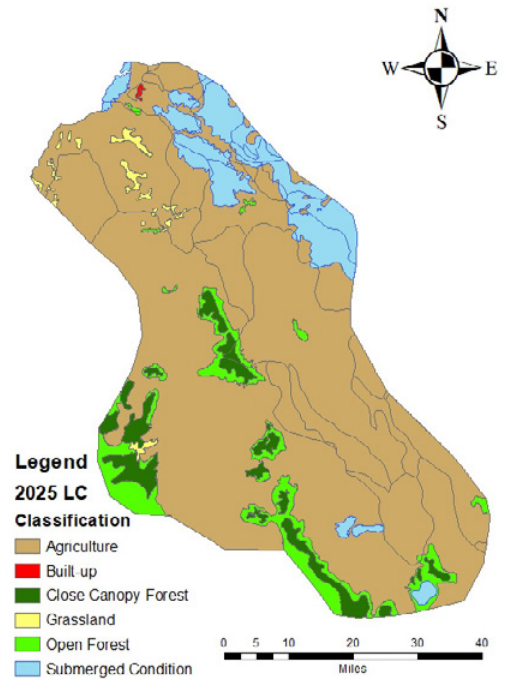
Fig. 6: Map of 2025 Projected Land Cover